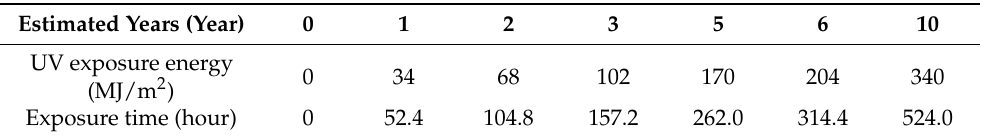
Table 2. UV exposure